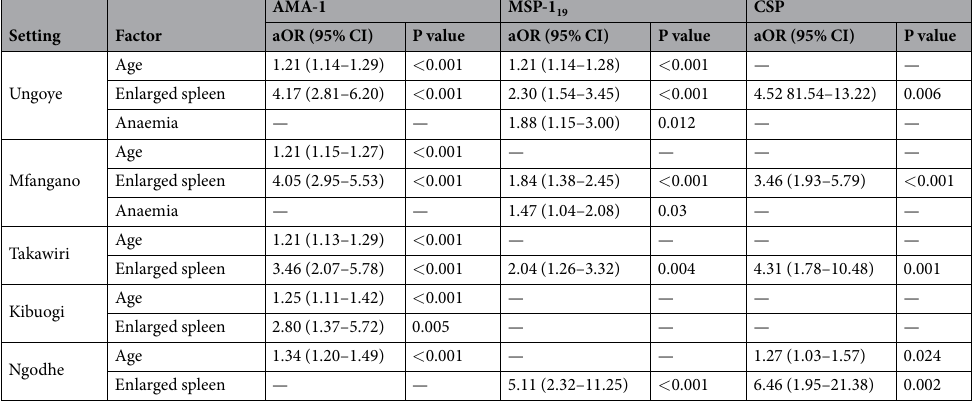
Table 4. Factor associated with P . falciparum seroprevalence among children ≤ 12 years old in four islands and a mainland village, Lake Victoria Kenya, 2012 * . * aOR, adjusted odd ratio; CI, confidence interval. Estimates are adjusted (i.e. age, gender, fever, anaemia and enlarged spleen) for correlation between observations from the same